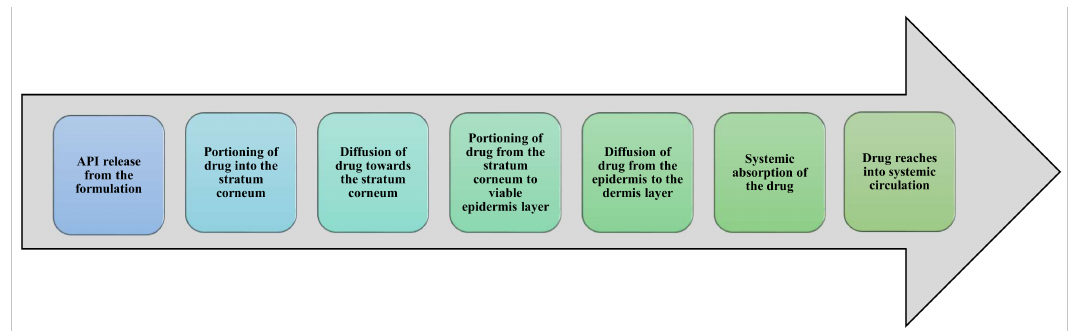
Figure 3. Representation of the different penetration pathways of the drug through the